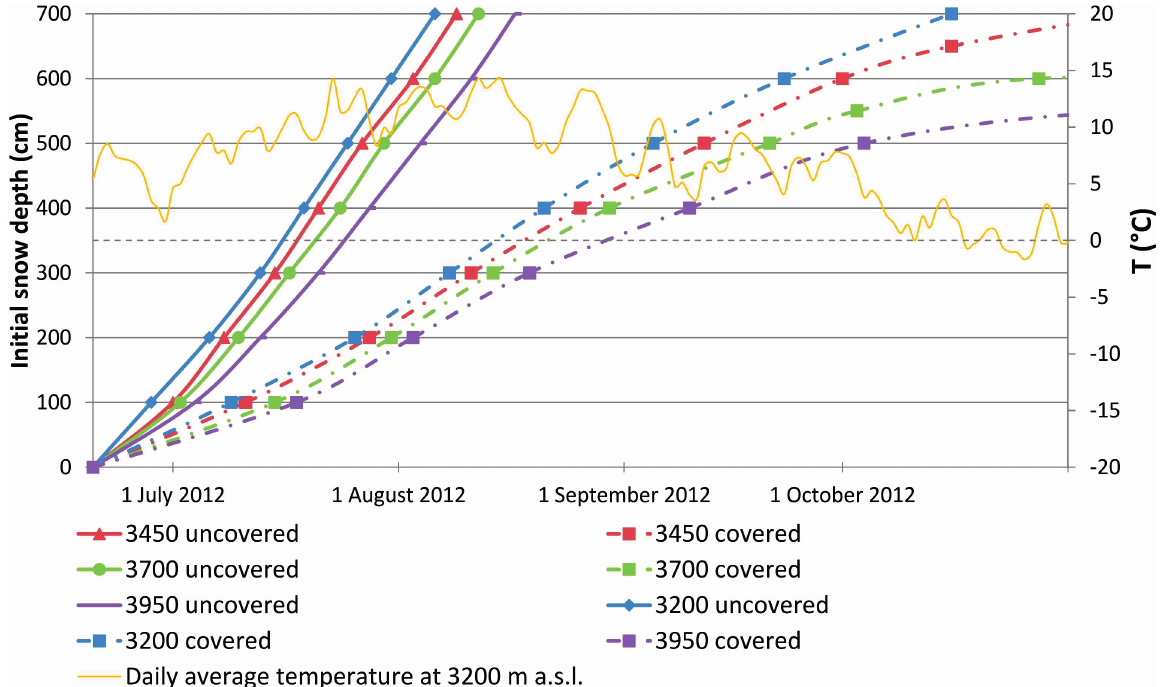
Figure 10. The survival date (symbols) of snow deposits depending on initial snow depth on four elevation levels integrating the effects of geotextile coverage modeled with the energy-balance